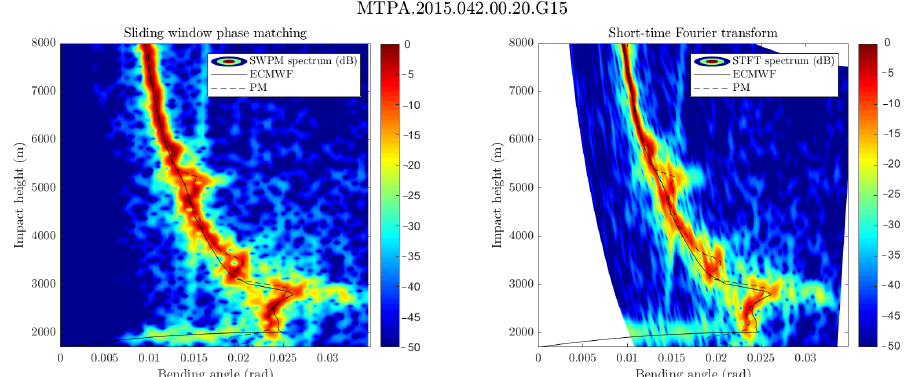
Figure 8. A MetOp-A occultation from UTC 0020 2015-02-10, 53.90 ◦ S, 3.86 ◦ E. Left shows SWPM, right shows STFT. ECMWF BA is shown in solid black, standard PM is shown in dashed black. The window length for STFT is 1.5